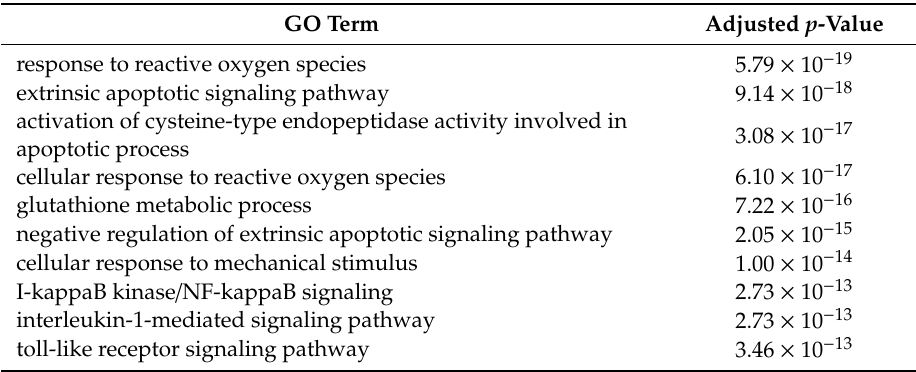
Table 1. Enrichment analysis of genes targeted by hydrogen-sulfide-containing compounds. The whole list of genes targeted by hydrogen-sulfide-containing compounds according to the CTD database [13] was submitted to an enrichment analysis. Enrichment in genes annotated with GO (gene ontology) terms of the “biological process” category was assessed using the enrichment analysis platform Enrichr [14]. To filter out GO terms corresponding to poorly specific biological functions, only GO terms annotating less than 100 genes were taken into account. Adjusted p-values provided by the Enrichr webtool were calculated with a modified Fisher exact test